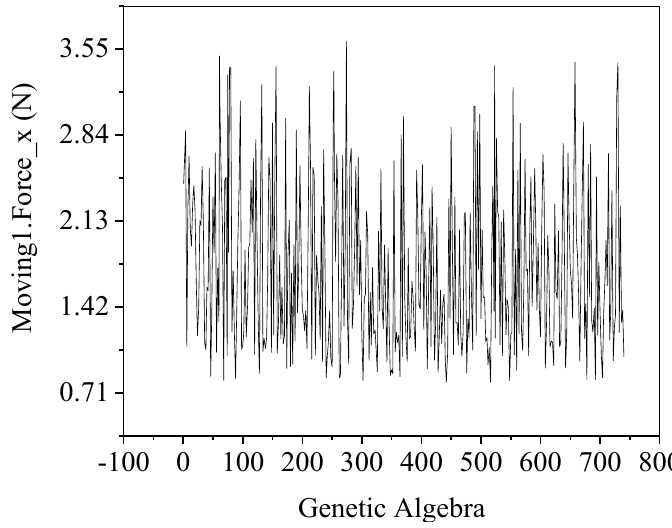
Figure 6. Genetic algorithm optimization. Table 2. Specific values of genetic algorithm optimization.